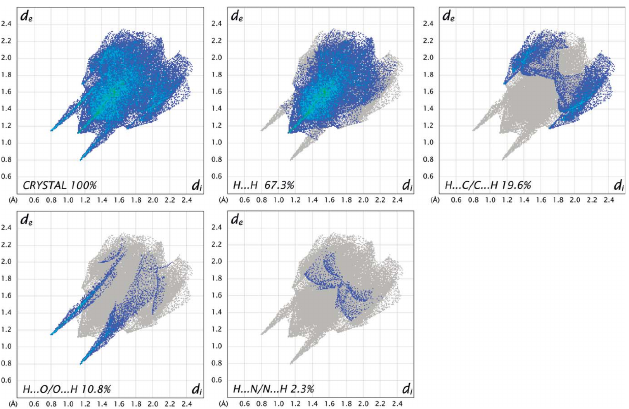
Figure 7 The full two-dimensional fingerprint plots for the rac -1 polymorph, showing all interactions, and delineated into H (cid:2)(cid:2)(cid:2) H, H (cid:2)(cid:2)(cid:2) C/C (cid:2)(cid:2)(cid:2) H, H (cid:2)(cid:2)(cid:2) O/O (cid:2)(cid:2)(cid:2) H and H (cid:2)(cid:2)(cid:2) N/N (cid:2)(cid:2)(cid:2) H interactions. The d i and d e values are the closest internal and external distances (in A˚ ) from given points on the Hirshfeld surface.